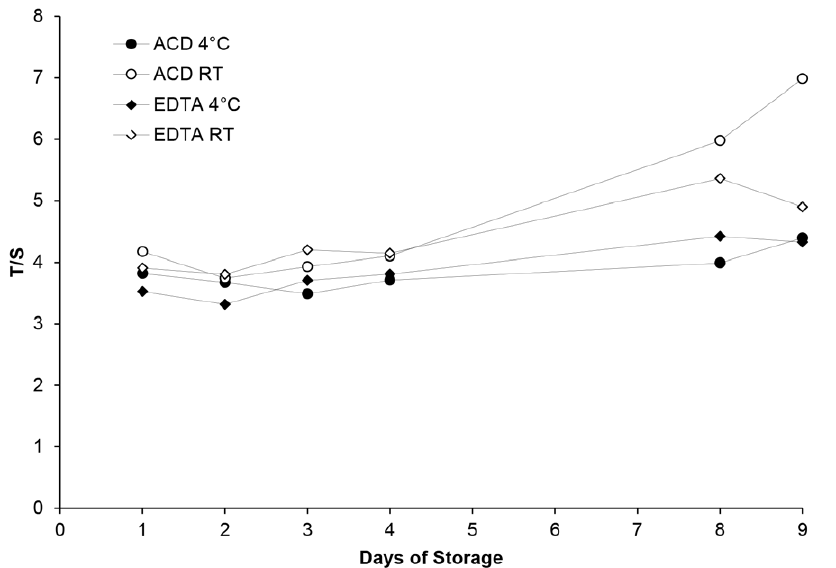
Figure 5. Stability of T/S measurements in anticoagulated whole blood samples in different storage conditions. ACD and EDTA anticoagulated whole blood was stored at 4 u C and room temperature (RT) for nine days, and daily T/S ratios are shown.